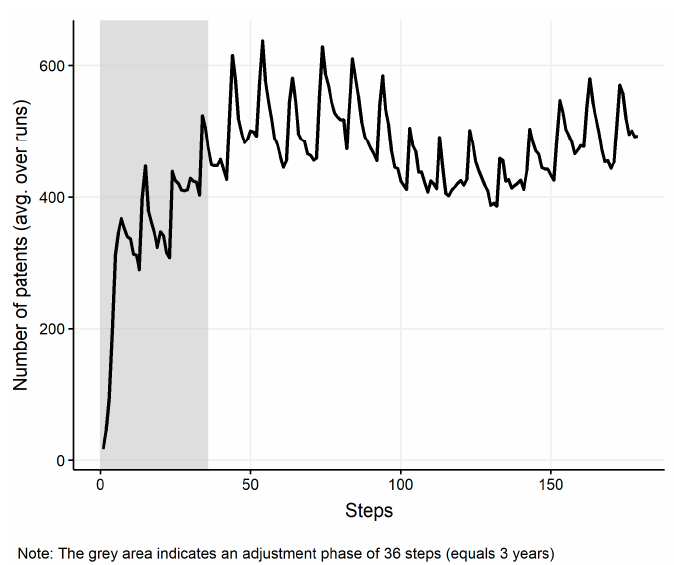
Figure A6. Number of patents per step (average over runs).